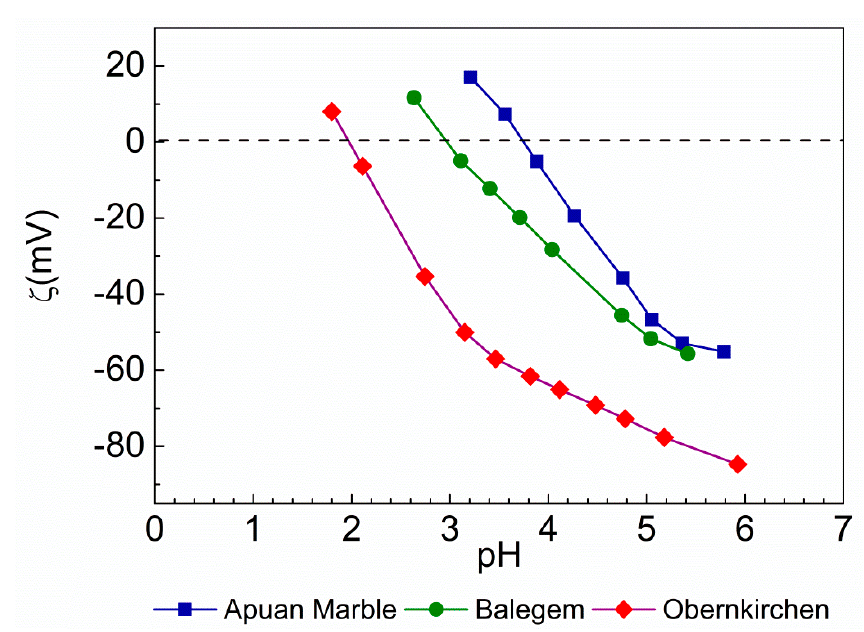
Figure 2. Example of titration curves expressing ζ potential as a function of pH for the three lithotypes: Apuan marble, Balegem limestone and Obernkirchen sandstone.